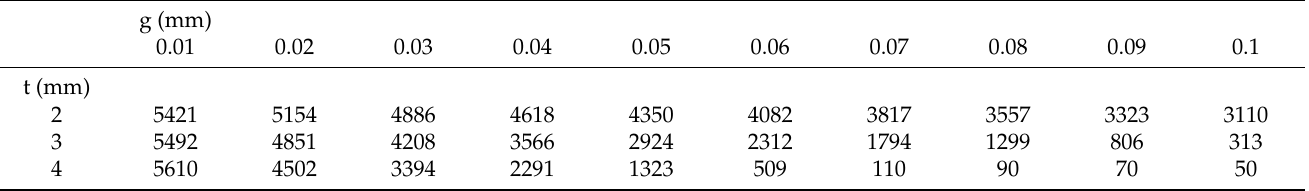
Table 3. Clamping torque (in Nm) for different combinations of gap (g) and membrane thickness (t) (p = 4 bar).